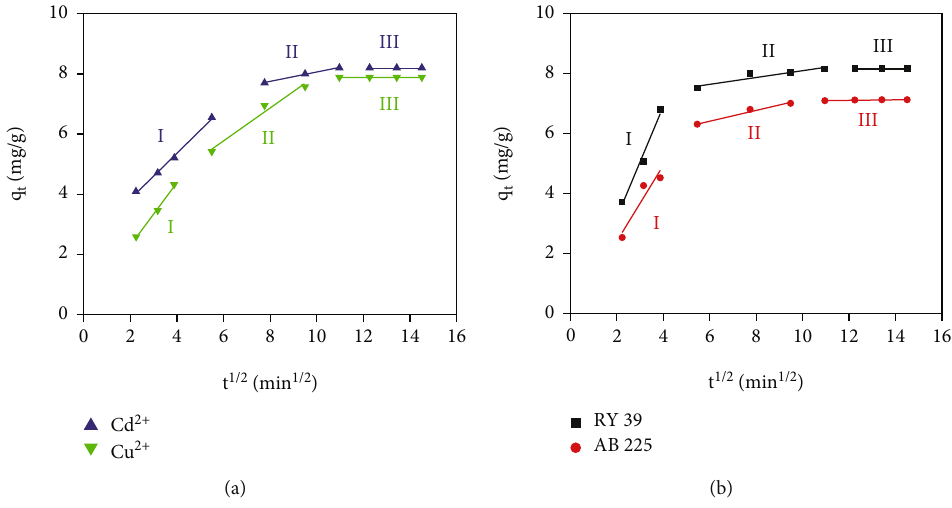
Figure 9: Intraparticle di ff usion plots of the metal ions and dyes onto